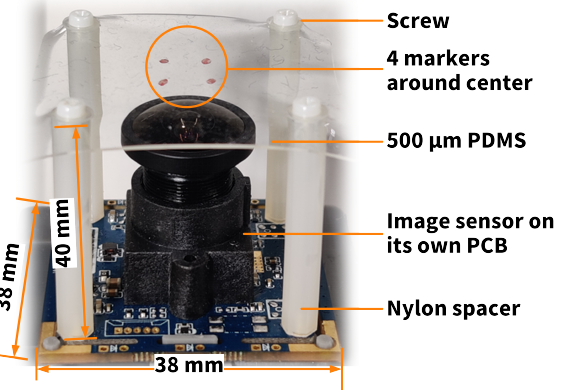
Figure 7. Prototype of the proposed vision-based tactile sensor. The top is a square PDMS film on which four markers are attached symmetrically near the center, and below which is a wide-angle image sensor on a PCB. These two components are isolated by four nylon